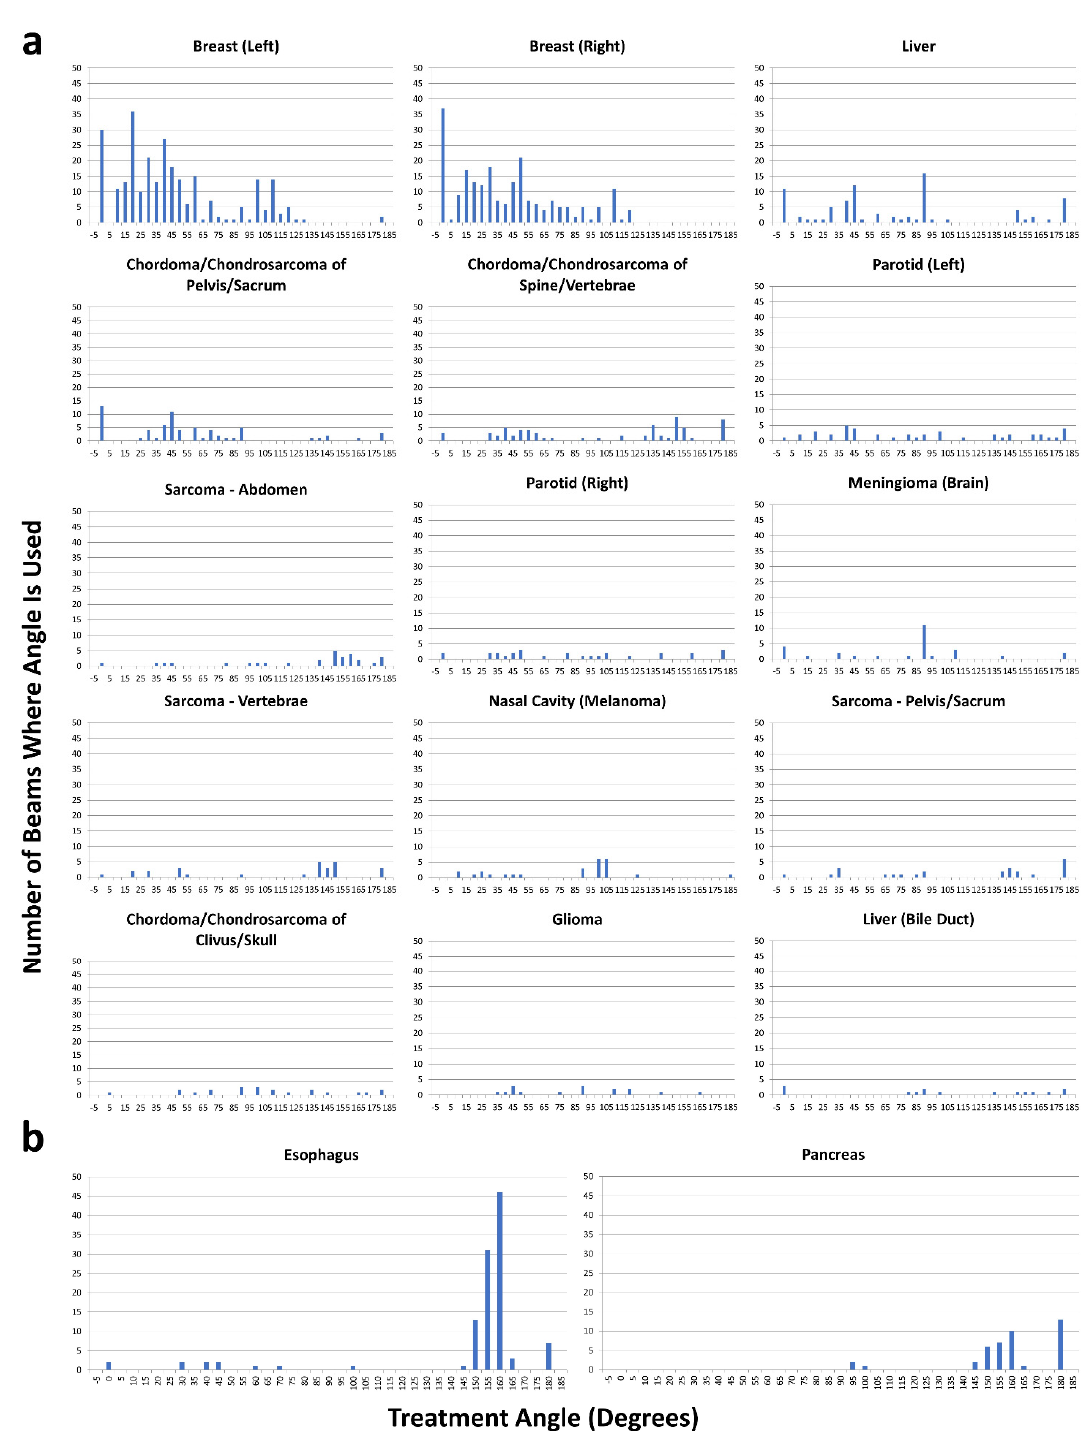
Figure 3. Histograms demonstrating the number of beams ( y -axis) used at each angle ( x -axis) by primary tumor treatment site. ( a ) Histograms generated for primary curative treatment plans for the anatomic primary tumor treatment sites utilizing the most treatment beams and having a multimodal distribution. ( b ) Histograms generated for esophagus and pancreas primary curative treatment plans. Only cancers of the esophagus were shown to have a predominantly unimodal grouping of beam angles, with 84% of the 112 beam angles fitting in the 160 ◦ ± 10 ◦ range, while cancers of the pancreas showed moderate bimodal grouping in beam angles, with 94% of the 42 beam angles fitting in either the 155 ◦ ± 10 ◦ range or 180 ◦